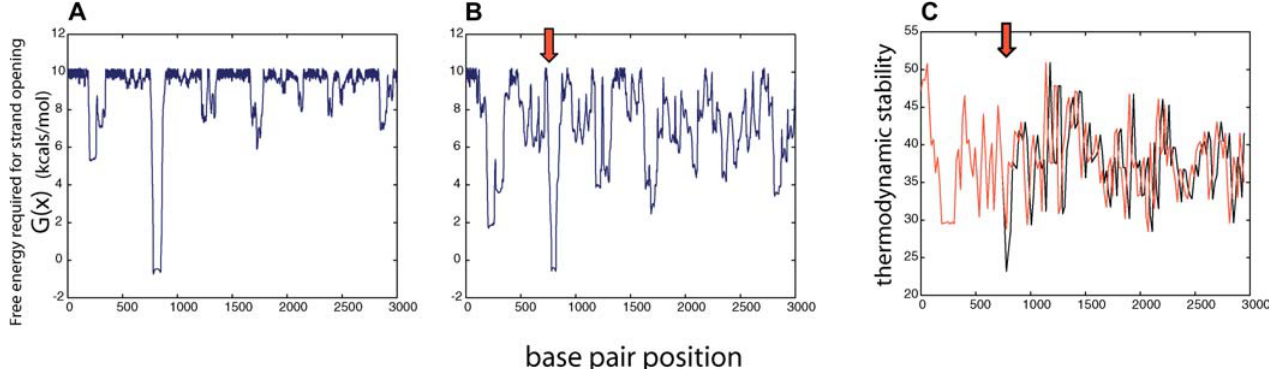
Figure 1. Comparison of Stress-Induced Duplex Destabilization Calculations with Assessments of Thermodynamic Stability (A) The SIDD profile showing the G ( x ) values computed for a 3-kbp region (525701–528700) on Chromosome X of yeast at superhelix density r ¼ (cid:1) 0.055. (B) The SIDD profile of a 38-bp deletion mutant of the same region [28], at the same superhelicity. The deletion is at positions 526489–526526, indicated by the red arrow. This deletion causes drastic changes of SIDD properties throughout the region, even 2 kbp away. This is an effect of the global coupling induced by the superhelical stresses. (C) Thermodynamic stability profiles of the same regions as computed by WEB-THERMODYN [12,13], both before (black) and after (red) the deletion. The only effect of this deletion, whose location is indicated by the red arrow, is to displace the downstream profile by 38 bp. However, as shown in (B), the SIDD profile is profoundly altered throughout the region. DOI: 10.1371/journal.pcbi.0010007.g001